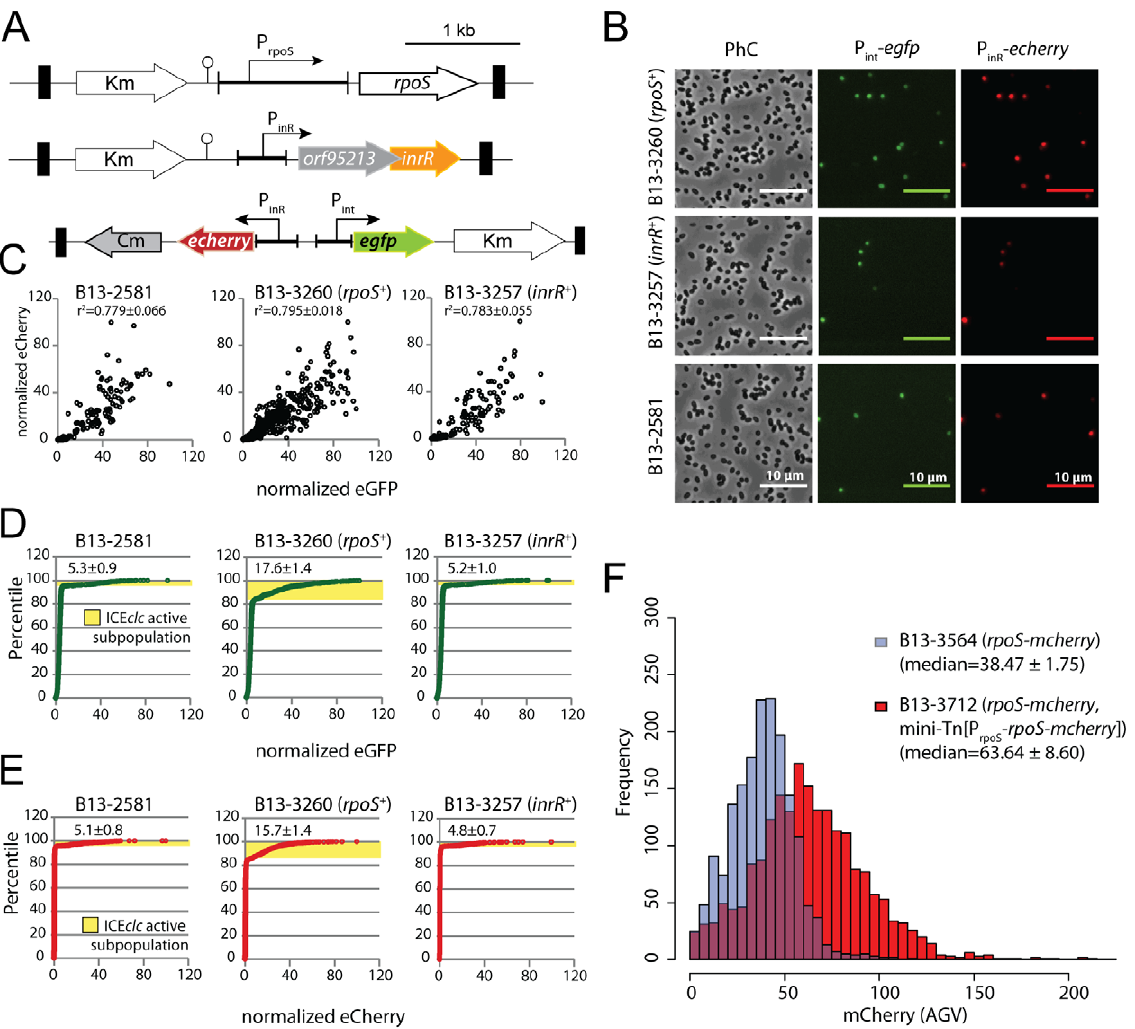
Figure 5. Effect of an additional copy of rpoS or inrR on the proportion of P.knackmussii B13 cells expressing P int and P inR in stationary phase. (A) Relevant construction details of the mini-transposon constructs used to deliver single copy rpoS , inrR or reporter genes. (B) Phase-contrast and corresponding epifluorescence micrographs (artificially colored green for eGFP and red for eCherry) of stationary phase cells grown on 3CBA at 1000 6 magnification. (C) Scatter plots showing correlation between normalized eGFP (from P int ) and eCherry fluorescence (from P inR ) in thousands of cells in B13-2581 (wild-type), B13-3260 (extra copy of rpoS ) or B13-3257 (extra copy inrR ). Correlation coefficients plus corresponding calculated standard deviations across biological triplicates are indicated. (D) Cumulative distributions of normalized eGFP fluorescence in strains of (C) and indication of the subpopulations of cells actively expressing P int (average from triplicates 6 SD ). (E) as (D), but for eCherry from P inR . (F) Effect of an extra copy of rpoS-mcherry on the scaled RpoS-mCherry fluorescence levels in stationary phase cells. Shown are distributions of mCherry fluorescence in cultures of B13-3564 ( rpoS-mcherry replaced rpoS , blue bars) and B13-3712 ( rpoS-mcherry replaced rpoS , extra copy rpoS- mcherry on mini-Tn insertion, red bars). Median values plus corresponding calculated standard deviations across biological triplicates are indicated in